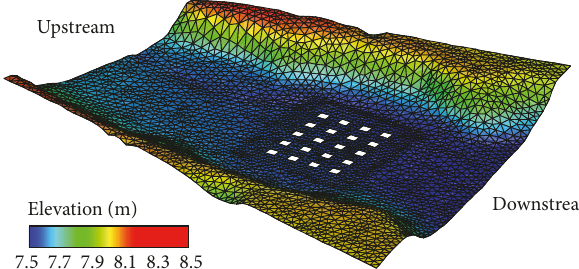
Figure 3: Schematic diagrams of Toce River experiment